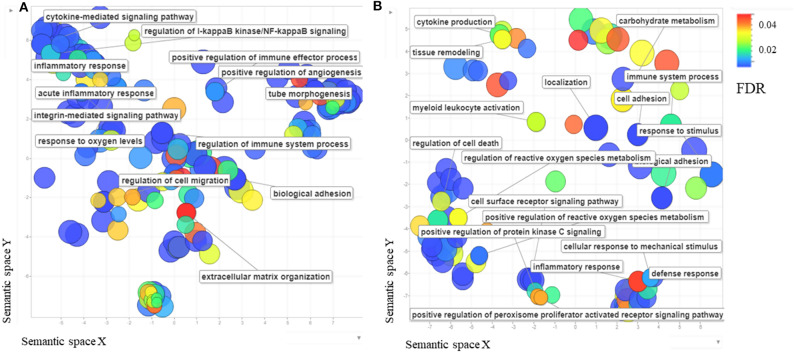
(A) The scatterplot shows the cluster representative genes of enriched biological process Gene Ontology (GO) terms among differentially expressed Bos taurus genes in Besnoitia besnoiti-infected BAEC cells at 32 hpi vs. non-infected BAEC summarized using REVIGO (Supek et al., 2011). (B) The scatterplot shows the cluster representatives of enriched biological process GO terms among differentially expressed Bos taurus genes in Besnoitia besnoiti-infected BAEC cells at 32 hpi vs. Besnoitia besnoiti-infected BAEC cells at 12 hpi summarized using REVIGO. The axes, semantic spaces x and y, mean that more semantically similar GO terms are closer in the plot.